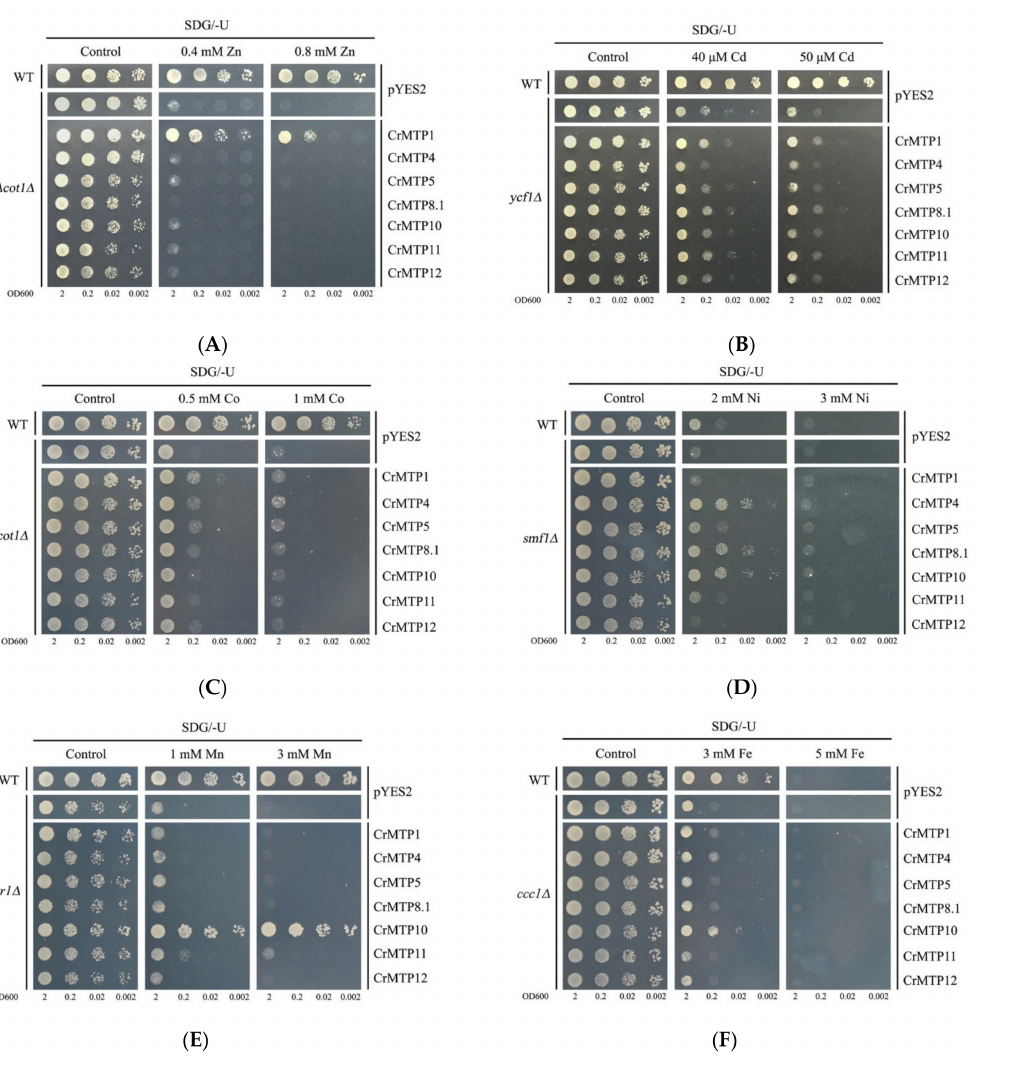
Figure 10. Complementation of yeast mutants on solid medium containing heavy metals. S. cerevisiae wild-type strain BY4741 was transformed with the empty vector pYES2, and mutant strains were transformed with the empty vector pYES2 or with the vectors carrying the CrMTP gene. Yeast cultures were adjusted to OD600 = 2, and 2 µ L of serial dilutions (10-fold, from left to right in each panel) were spotted on SDG–Ura medium supplemented with 0.4 or 0.8 mM ZnSO 4 ( A ), 40 or 50 µ M CdCl 2 ( B ), 0.5 or 1 mM CoCl 2 ( C ), 2 or 3 mM NiCl 2 ( D ), 1 or 3 mM MnCl 2 ( E ), and 3 or 5 mM FeCl 2 ( F ) on SDG–Ura plates. The corresponding yeast spots growing on SDG–Ura plates without heavy metals were used as controls. The plates were incubated for 2–5 days at 30 ◦ C. The images are representative of three independent